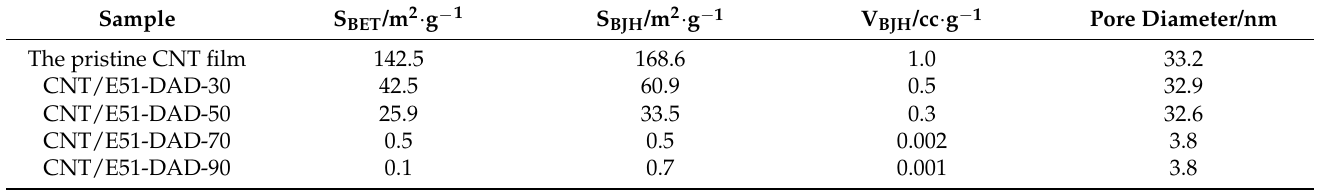
Table 2. The specific surface areas and pore diameters of the pristine CNT film and the CNT composite films after infiltrating the E51-DAD resin.